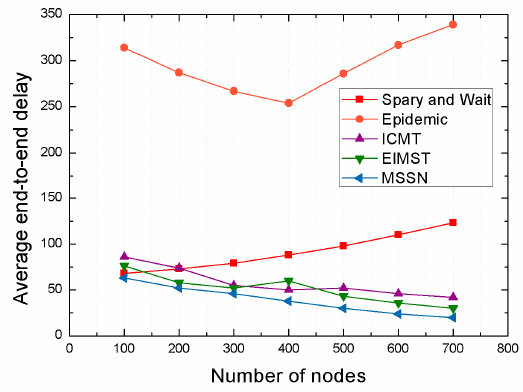
Figure 9. Average end-to-end delay with different number of nodes.